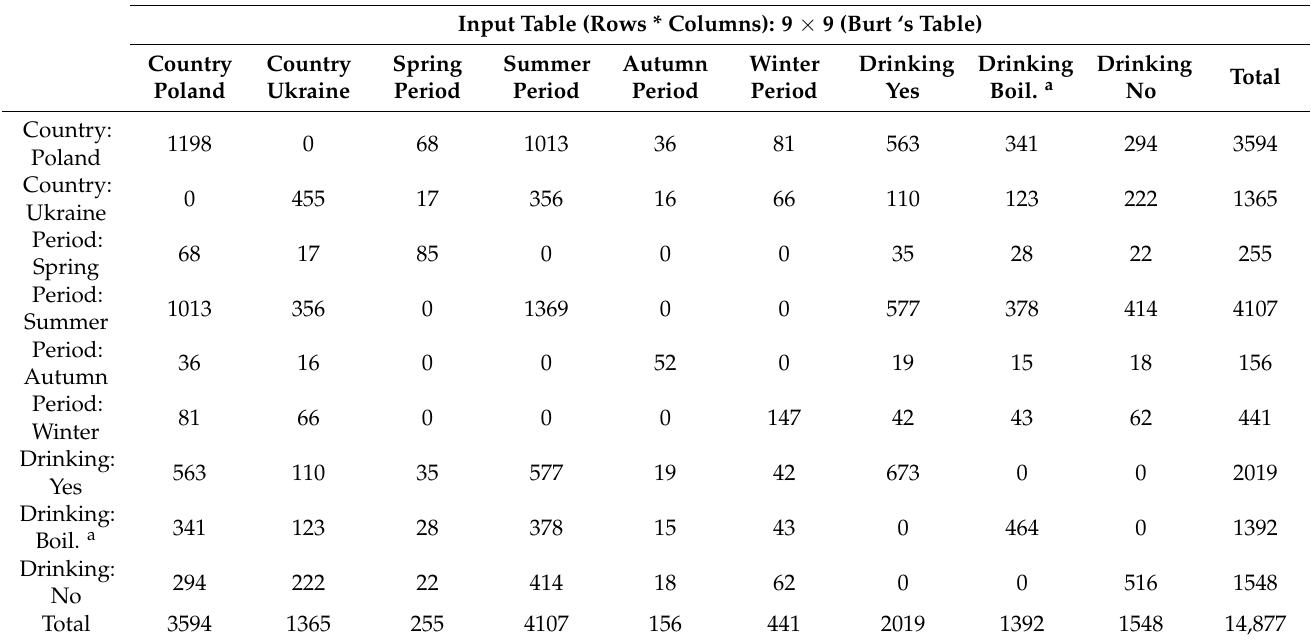
Table 4. Distribution of frequency profiles observed among respondents regarding country, period of consumption of the largest amount of tap water supplied and the use of tap water directly for drinking without boiling. Frequencies Observed Input Table (Rows * Columns): 9 × 9 (Burt ‘s Table)